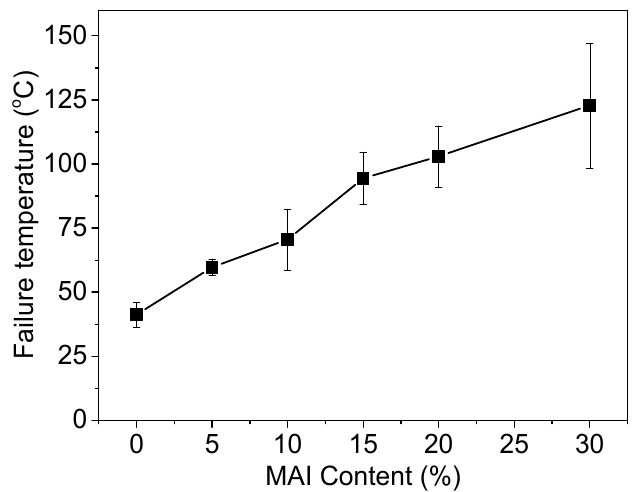
Figure 8. Shear adhesion failure test (SAFT) results on SPSA influenced by MAI content.